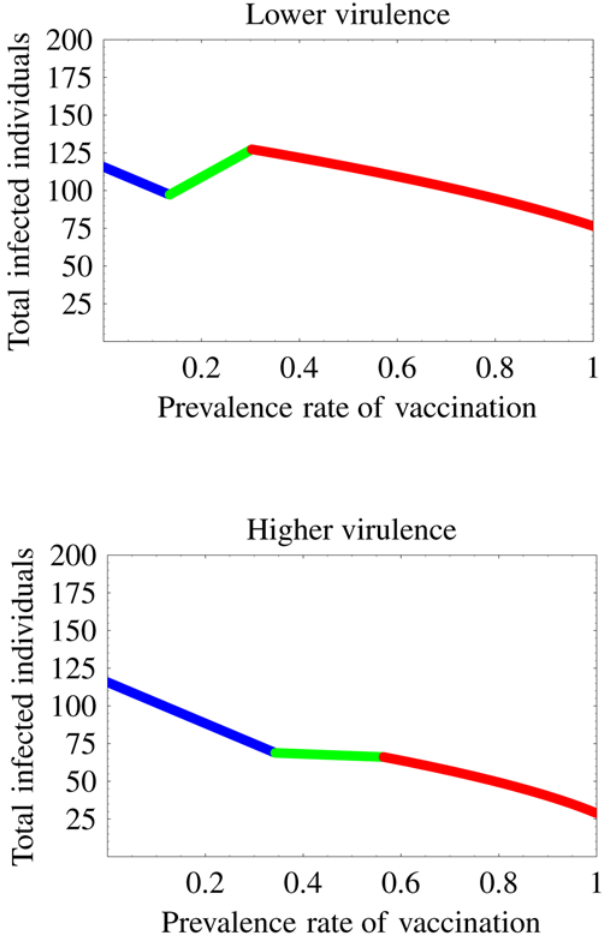
Figure 2. Final size of epidemics related with the prevalence rate of the vaccination: The top figure represents that the vaccination is not always effective in the case of lower virulence of vaccine-resistant strain. The bottom figure represents that the vaccination is always effective in the case of higher virulence of the vaccine-resistant strain. We assume that s =0.35, mz =0.045 (top) and mz =0.065 (bottom). These values of s and mz are not so influential on the result. The blue, green, and red lines respectively signify situations in which only the vaccine-sensitive strain exists, both the vaccine-sensitive and the vaccine-resistant strains exist, and only the vaccine-resistant strain exists.